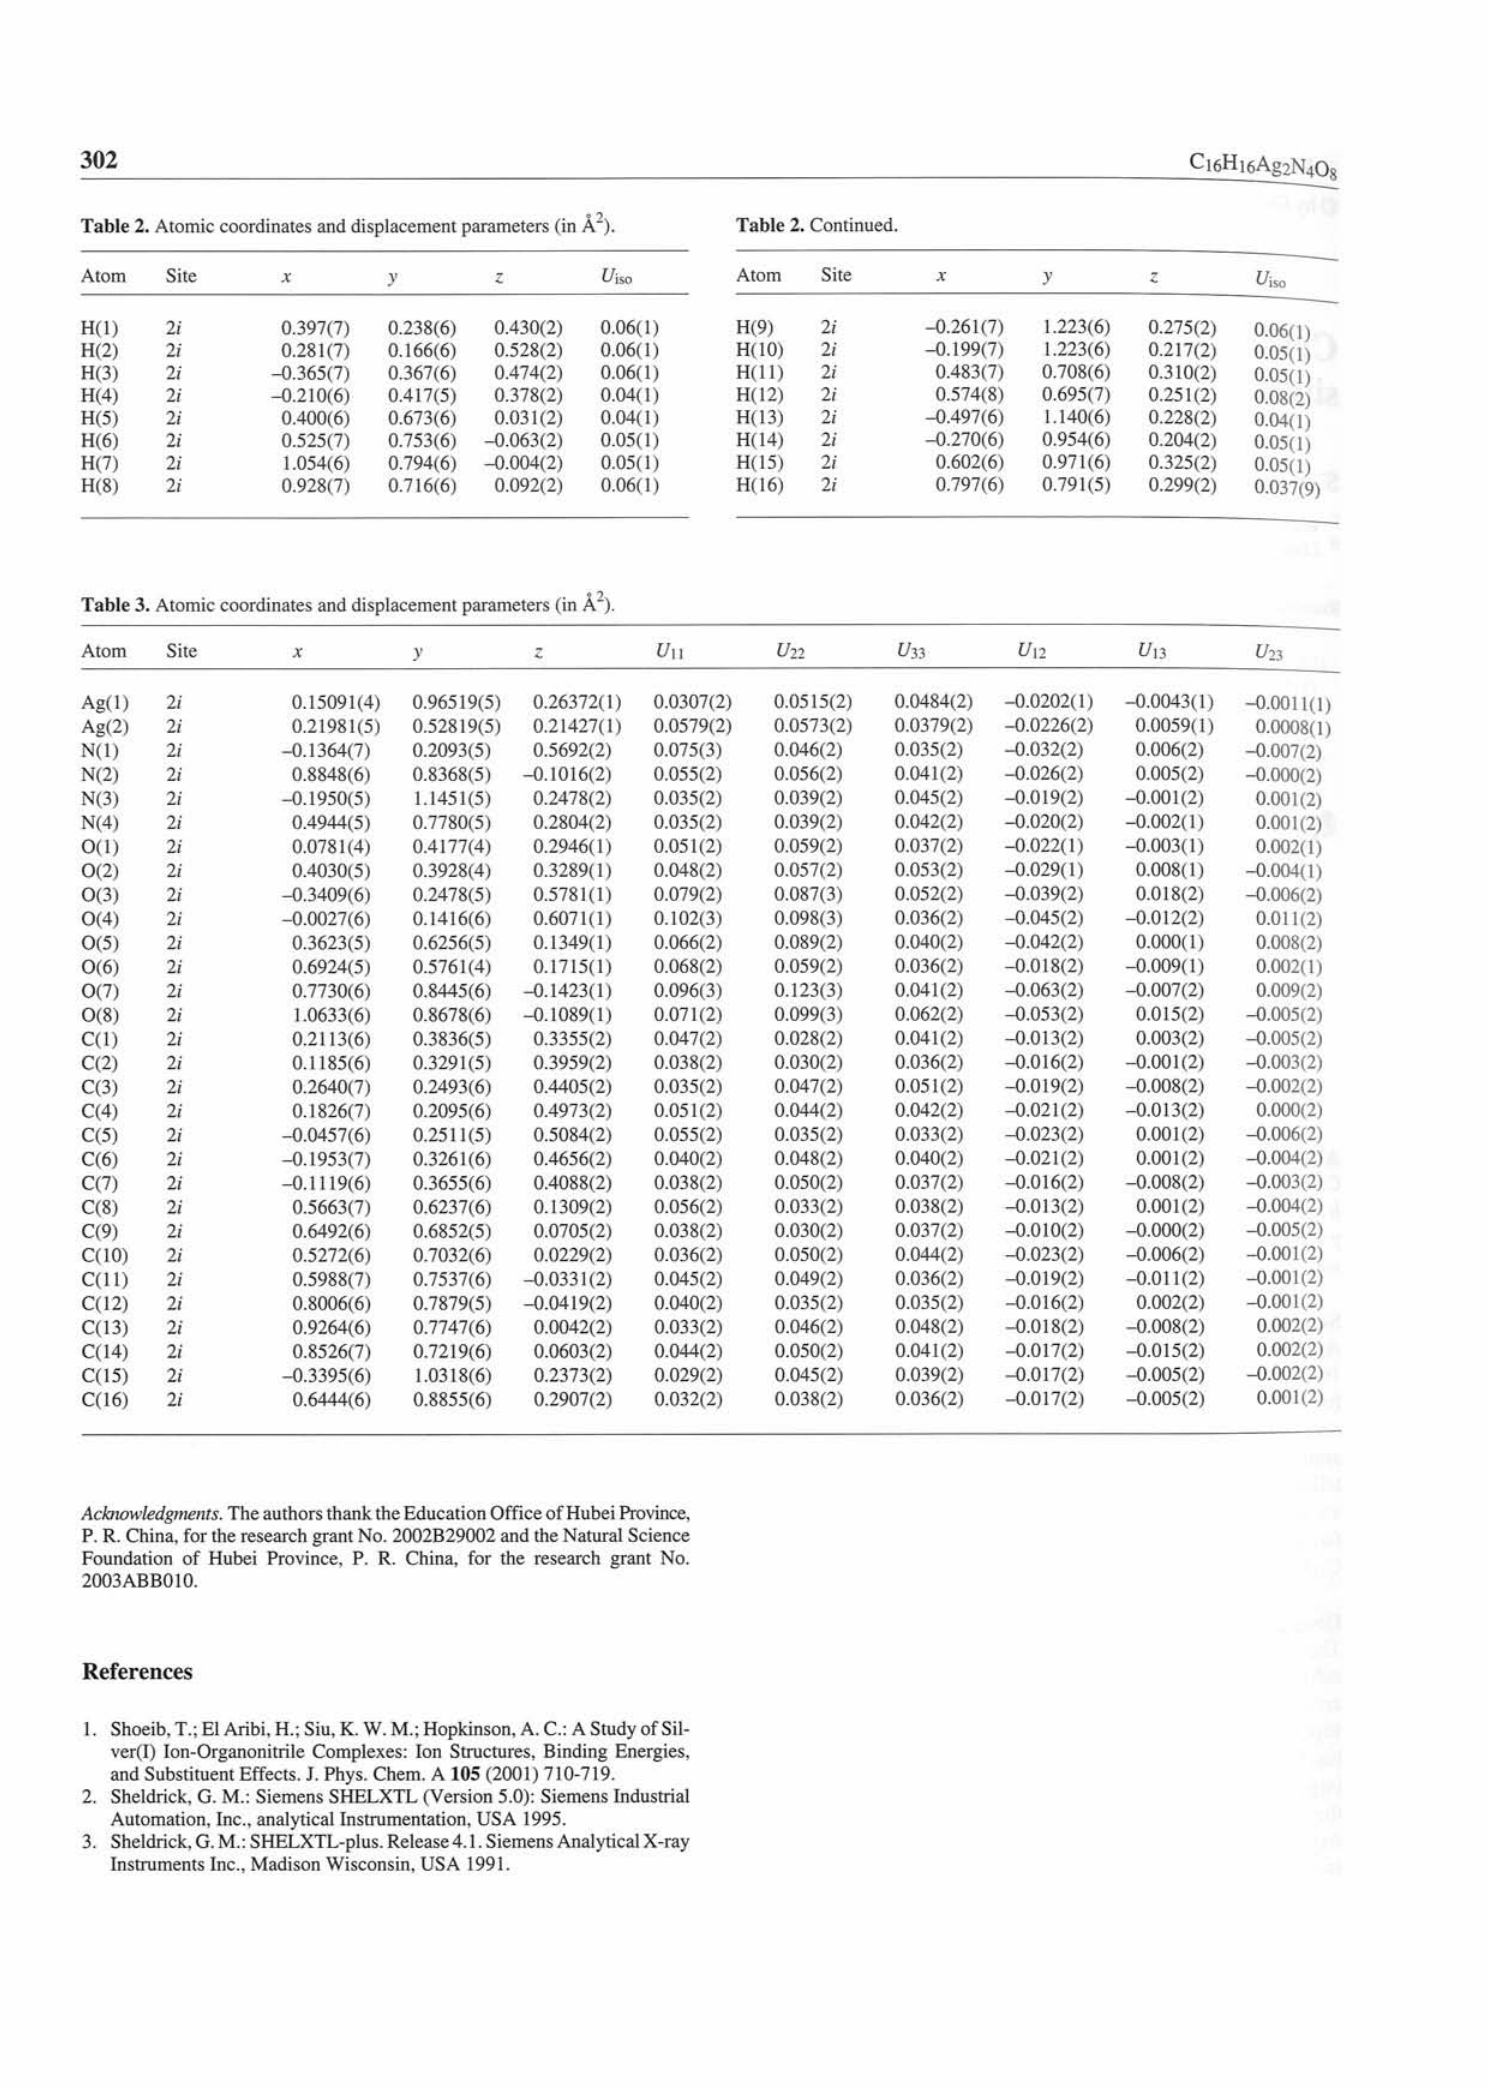
Table 3. Atomic coordinates and displacement parameters (in Á 2